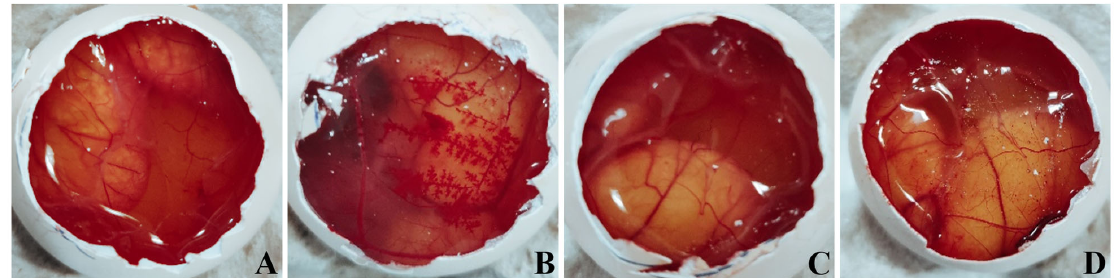
Figure 7. Images obtained from the HET-CAM test following the exposure of the CAM membrane to ( A ) negative control (0.9% w/v NaCl); ( B ) positive control (0.1 N NaOH); ( C ) blank dual-responsive in situ gel and ( D ) NEB-loaded dual-responsive in situ gel.